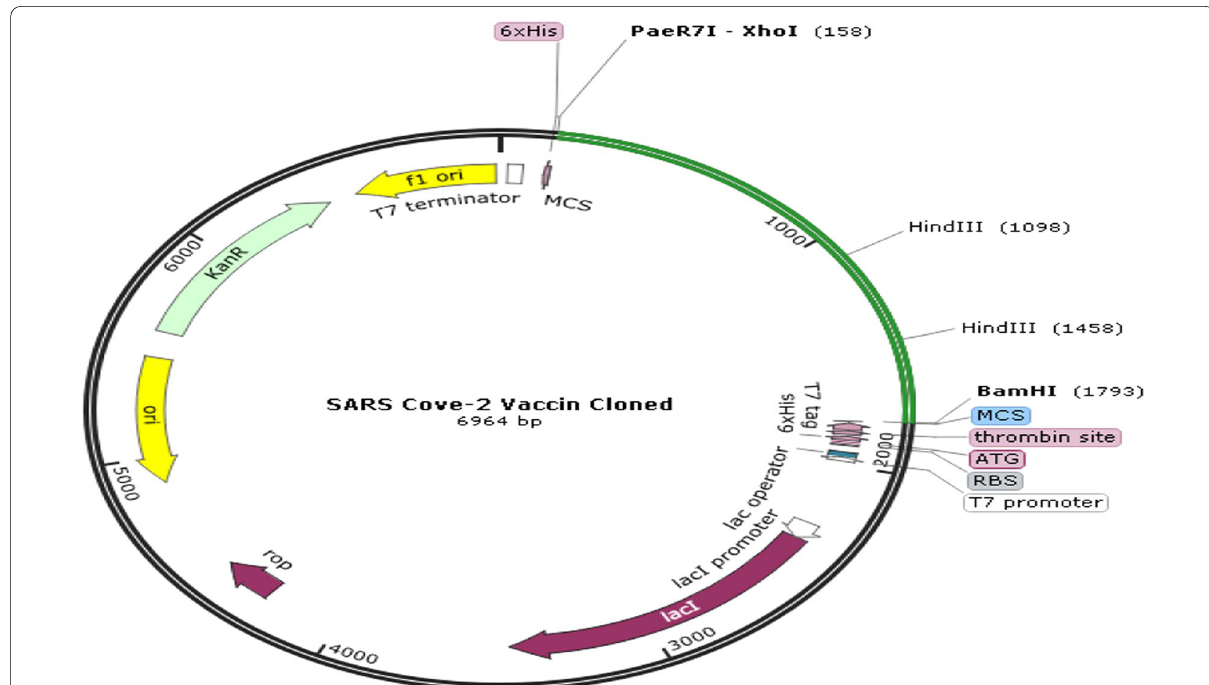
Fig. 4 Clone of the designed vaccine construct. The optimized codon sequence of the designed vaccine construct (shown in green) was cloned between the XhoI and BamHI enzyme loci in the expression vector pET-28a (